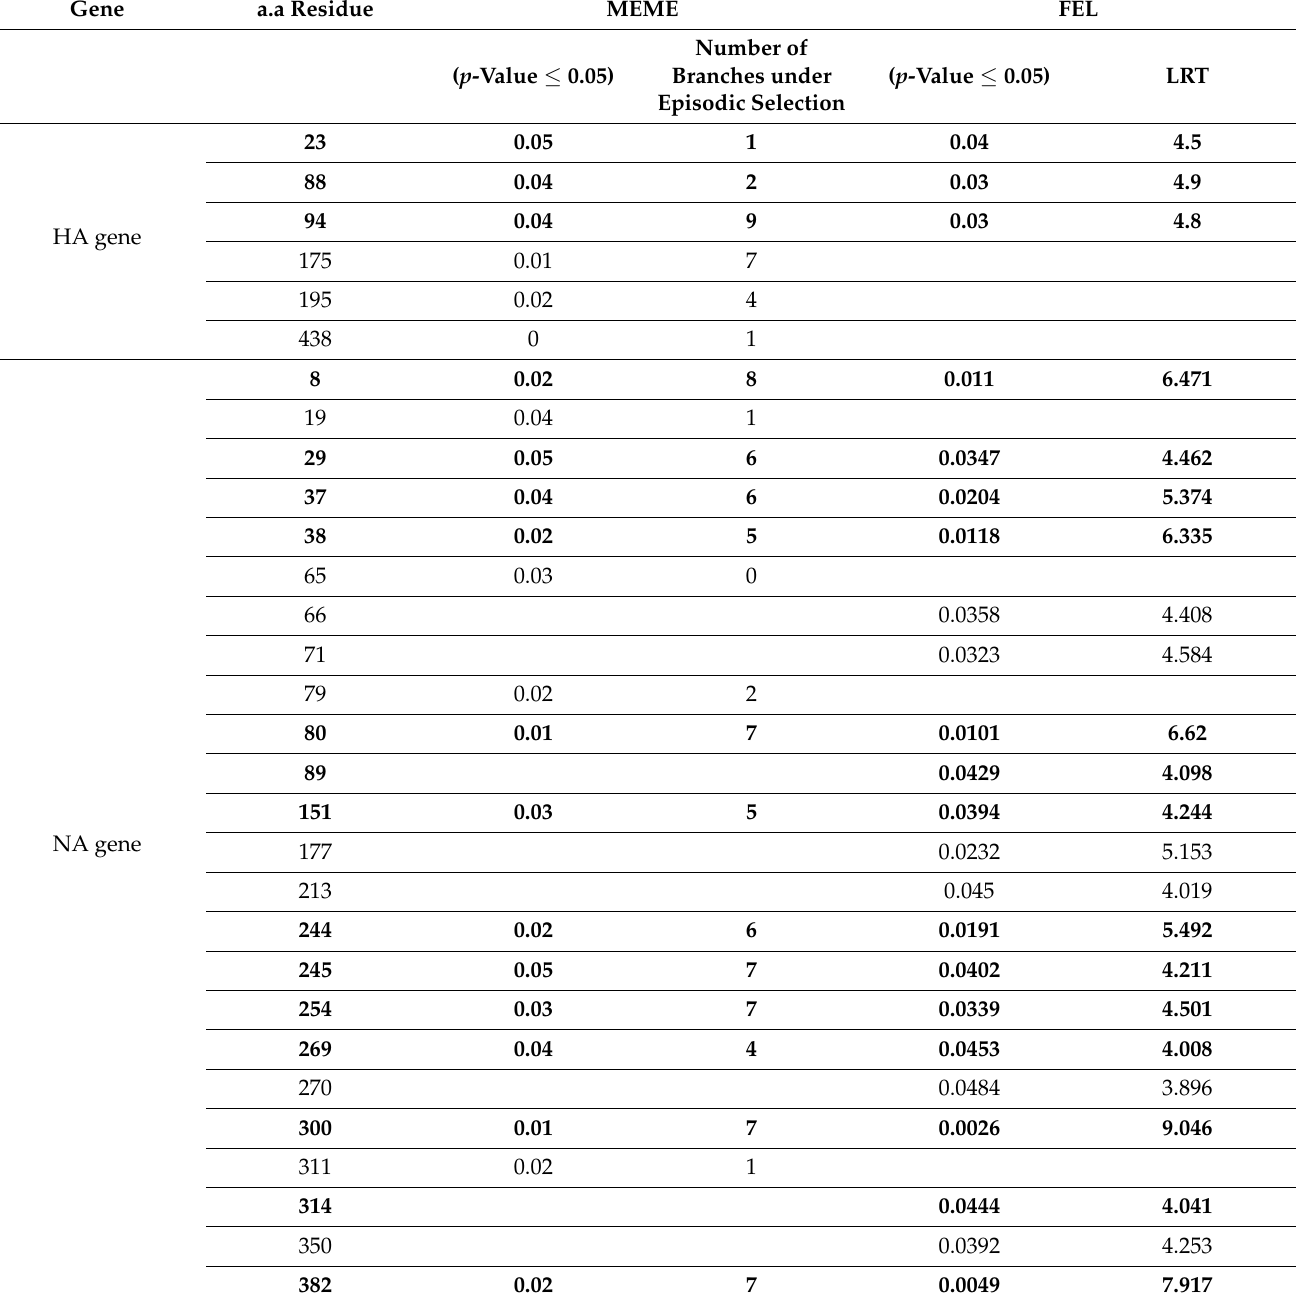
Table 2. Amino acid sites under positive selection pressure estimated using different analytical methods in both HA (H5 numbering) and NA. Amino acids (a.a) detect in both methods are shown in